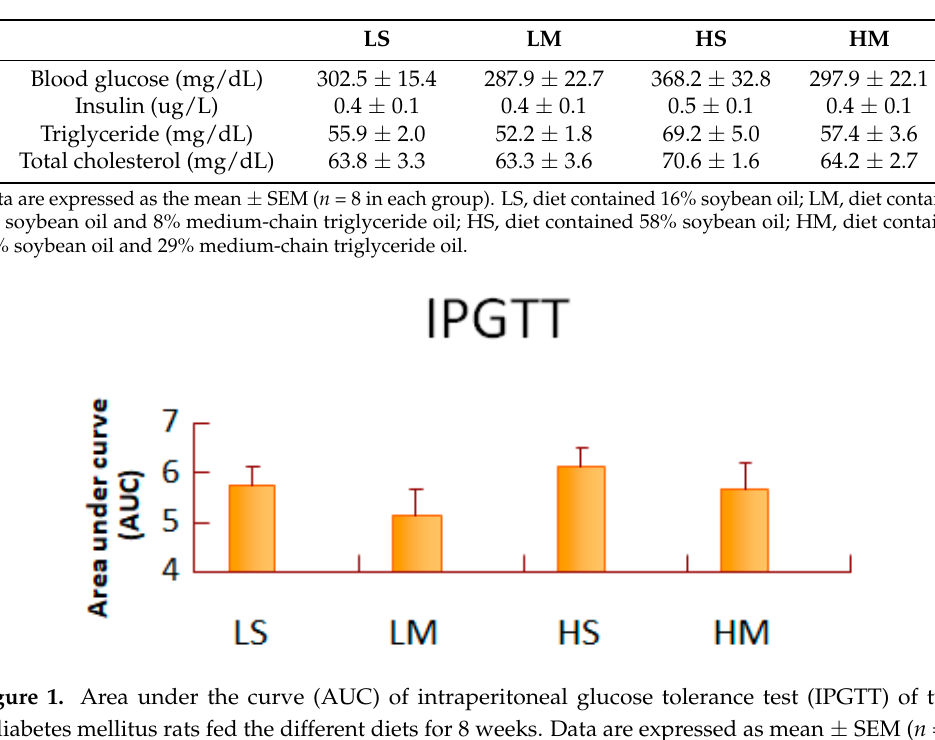
Table 2. Blood glucose, insulin, triglyceride, and total cholesterol concentrations of type 2 diabetes mellitus rats fed the different diets for 8 weeks.